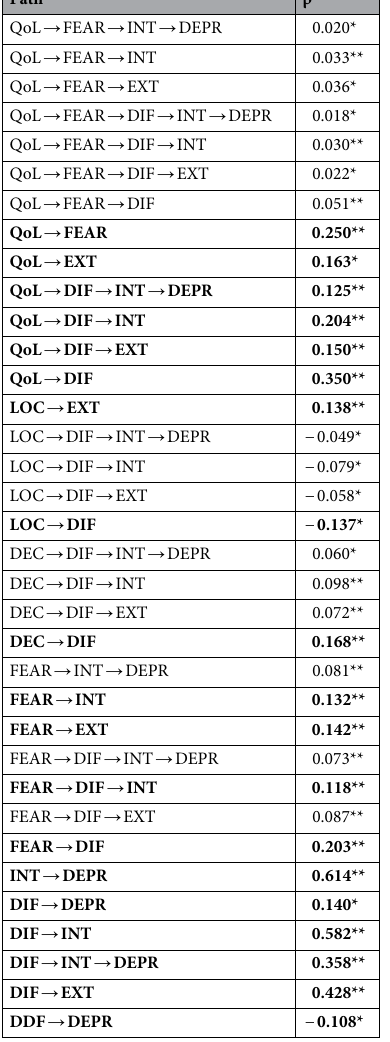
Table 4. Direct and Indirect Effects (* p < 0.05; ** p < 0.01). Significant values are in bold.